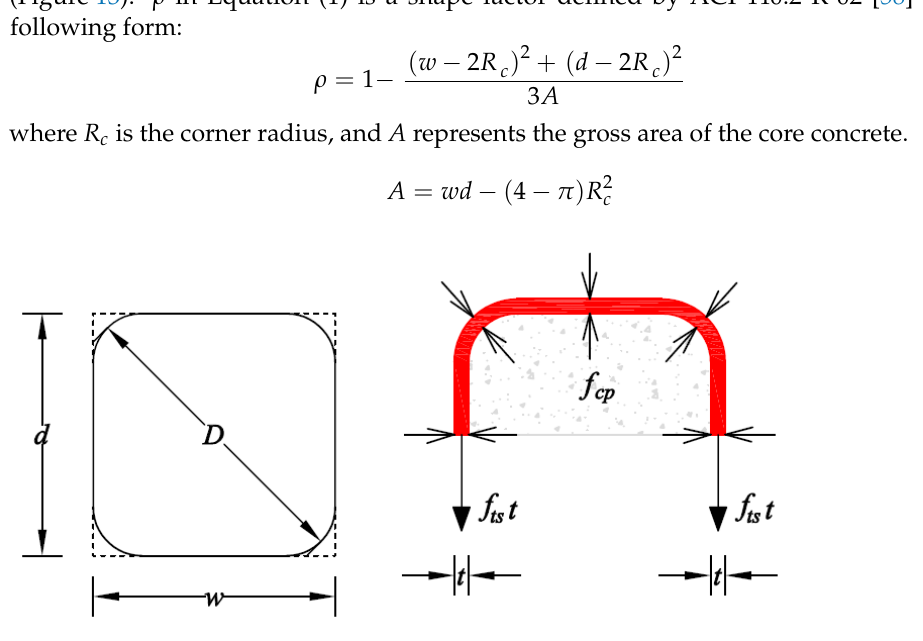
Figure 13. FRP confinement of square sections.